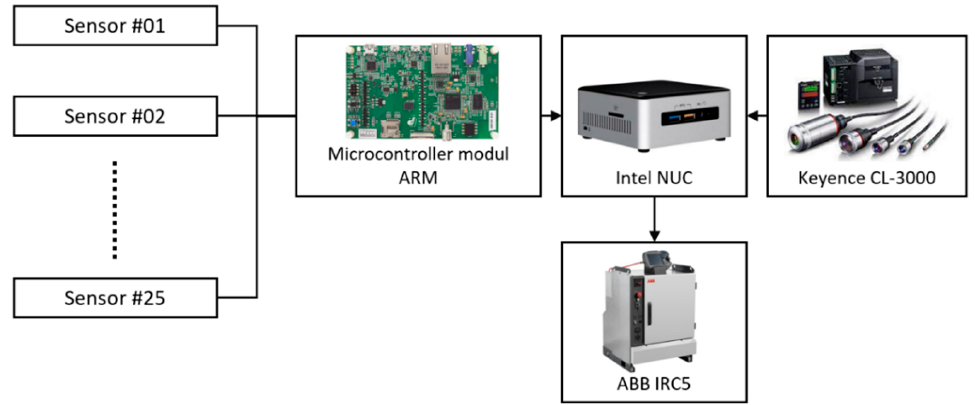
Figure 3. Block diagram of the measuring system.